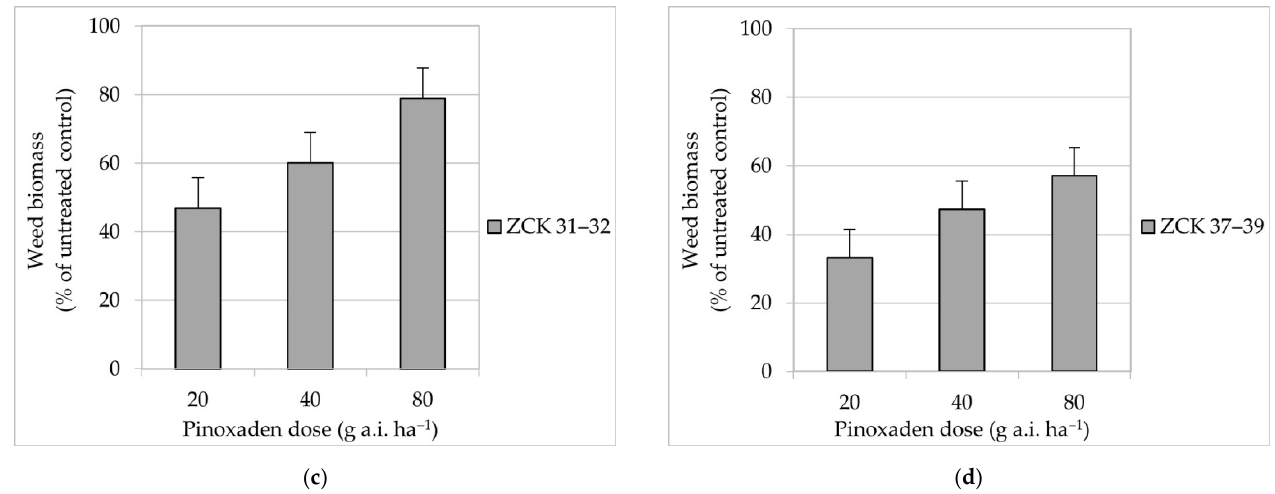
Figure 2. Biomass reduction (% of untreated control) of A. myosuroides plants treated with the various pinoxaden doses at ZCK 12–14 ( a ), ZCK 21–25 ( b ), ZCK 31–32 ( c ) and ZCK 37–39 ( d ). Vertical lines indicate a statistical difference according to Fisher’s Least Significant Difference (LSD) test at p < 0.05. LSD ( a ) = 2.68; LSD ( b ) = 2.23; LSD ( c ) = 8.93; LSD ( d ) = 8.18.